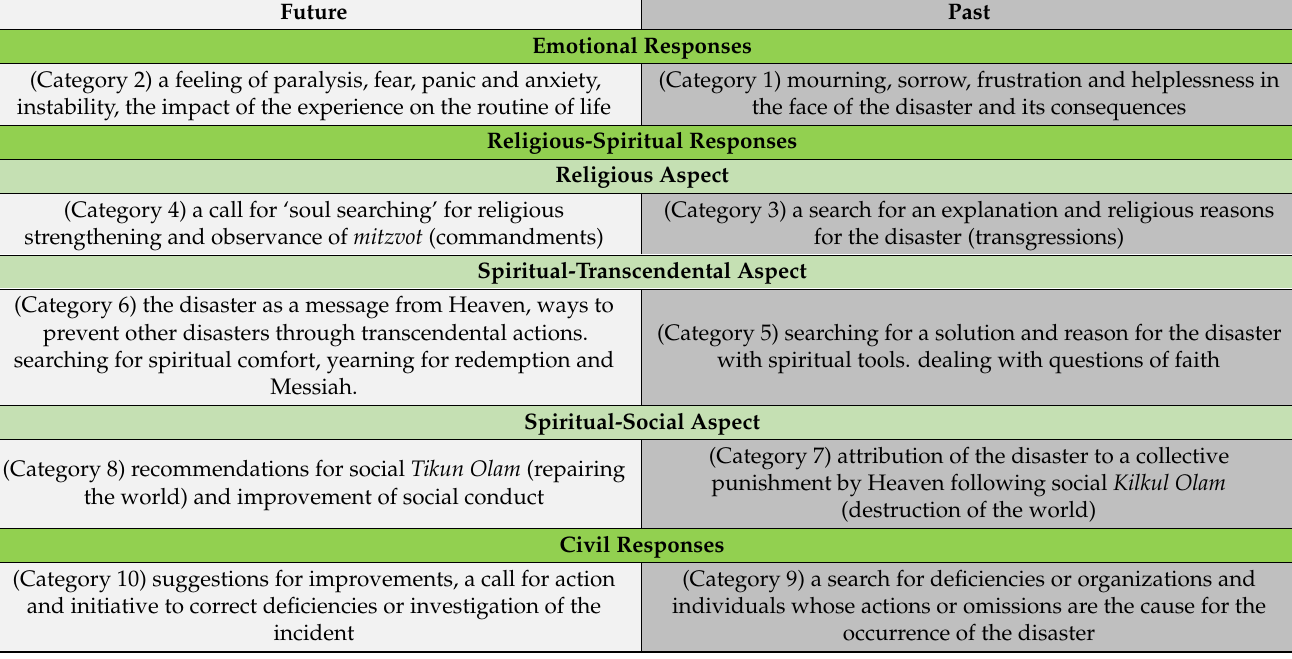
Table 1. A Model of the Response Styles to the Meron Crowd Crush in the Haredi